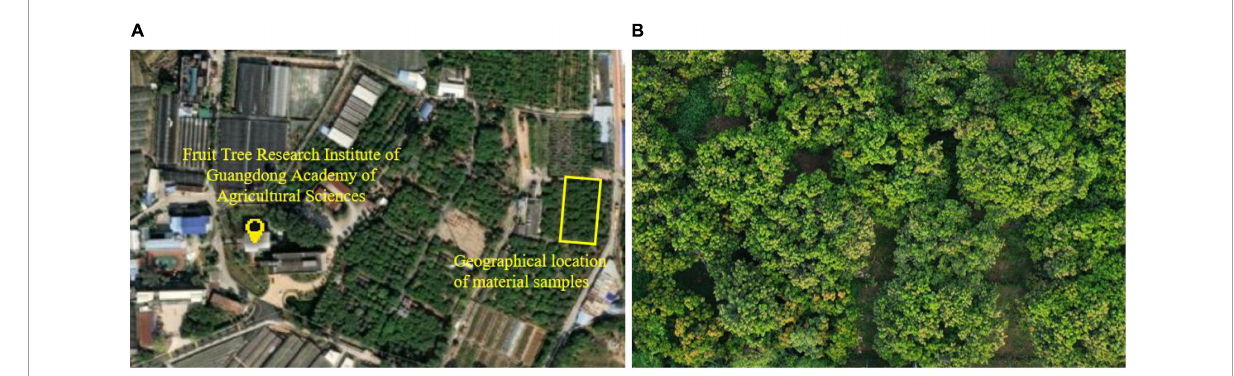
FIGURE2 Geographical location of the material samples and the top view of the litchi orchard during the flowering period. (A) Geographical location of material samples. (B) Top view the of litchi orchard during the flowering